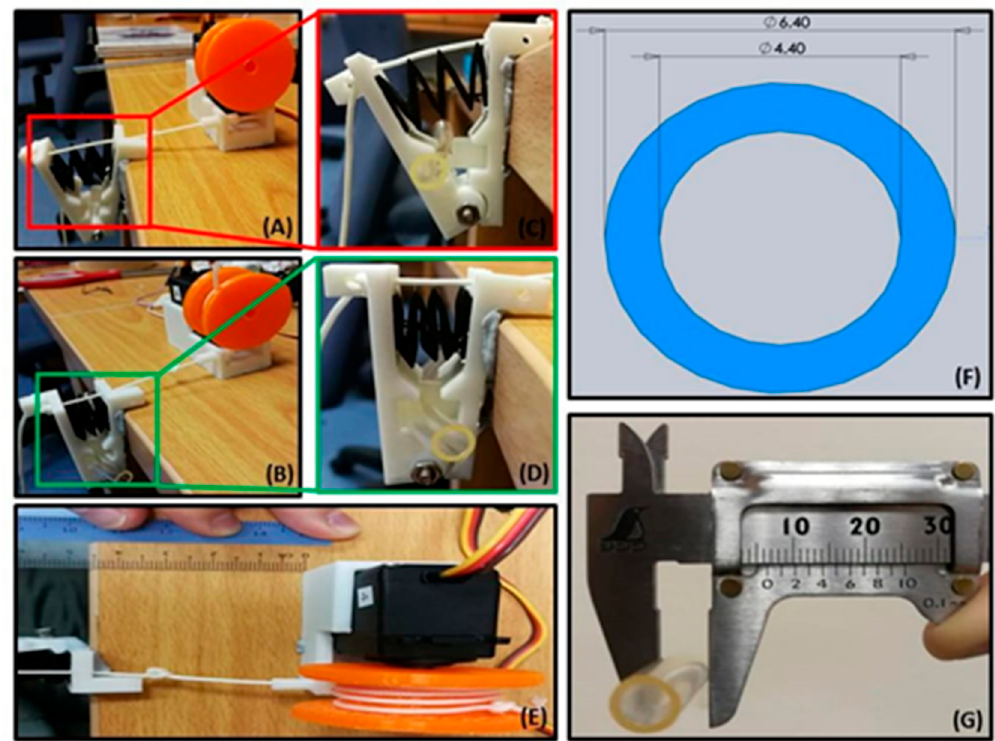
Figure 9. Gripper Actuation when blood concentration of 18 percent was detected, as shown in ( A,C ). The gripper is loosened to allow saline water to flow to wash the bladder. Gripper Actuation is shown in ( B,D ) when a blood concentration of 0.141 percent was detected. When less in gross hematuria is detected by the sensor probe, the gripper will tighten and reduce the inner diameter of the tube, reducing flow rate, thus saving up saline water when its use is not necessary. The distance between the Servo motor and gripper is 4.6 cm, as shown in ( E ). The further distance between the gripper and the servo motor would require more force for the servomotor to actuate the gripper. The dimension of Saline Tube is in ( F ) and measurement of the saline tube using Vernier Caliper ( G ). As shown in the measurement, the inner diameter of the tube is only 4.6 mm, which means the tube is completely sealed when the outer diameter is measured at 2.0 mm.